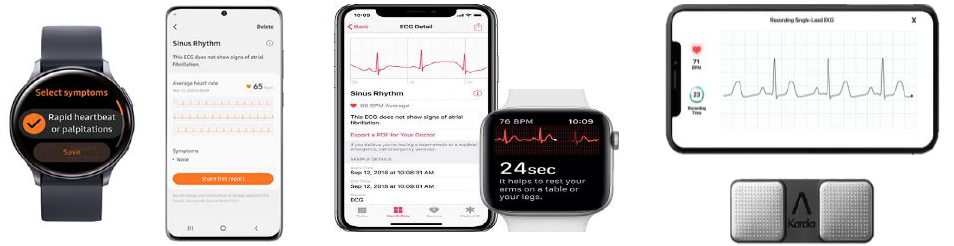
Figure 2. Wearable device based biosignal acquisition